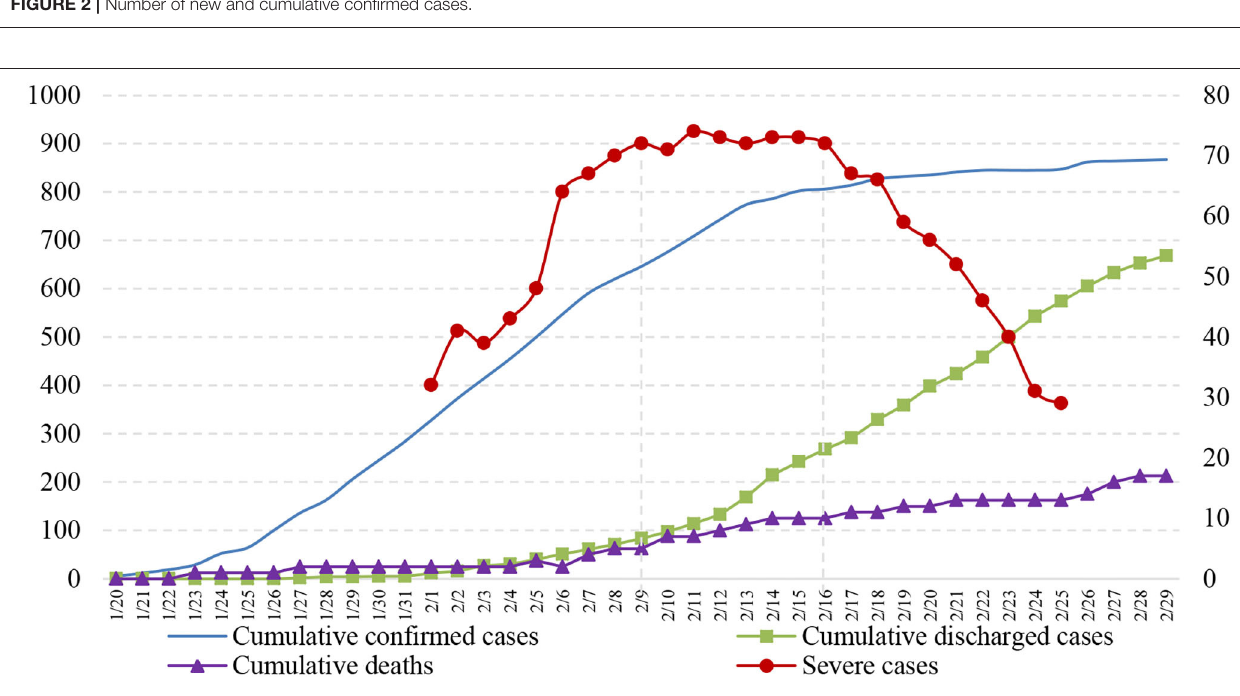
FIGURE 3 | Hospitalization of confirmed